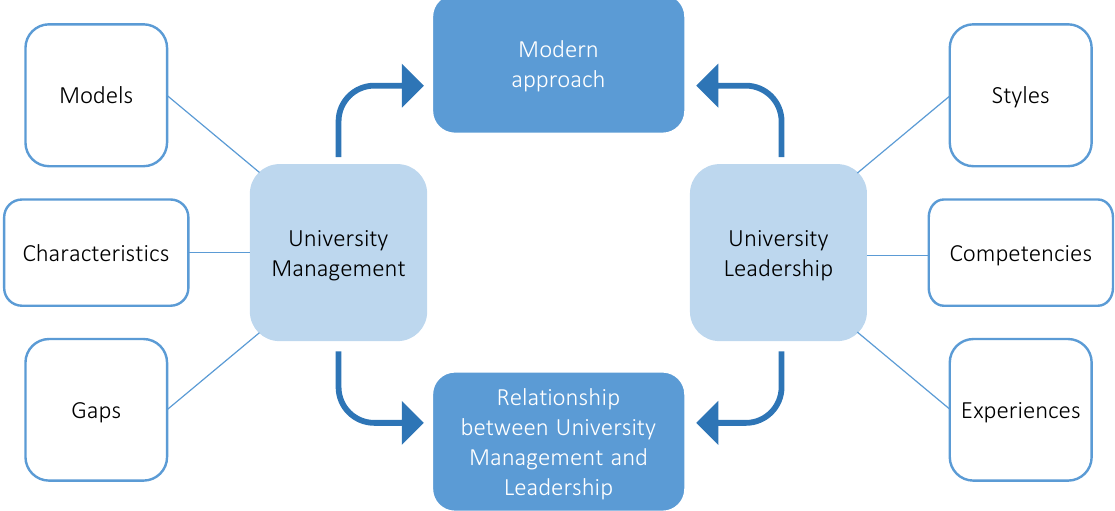
Figure 5. Aspects analyzed in the literature review